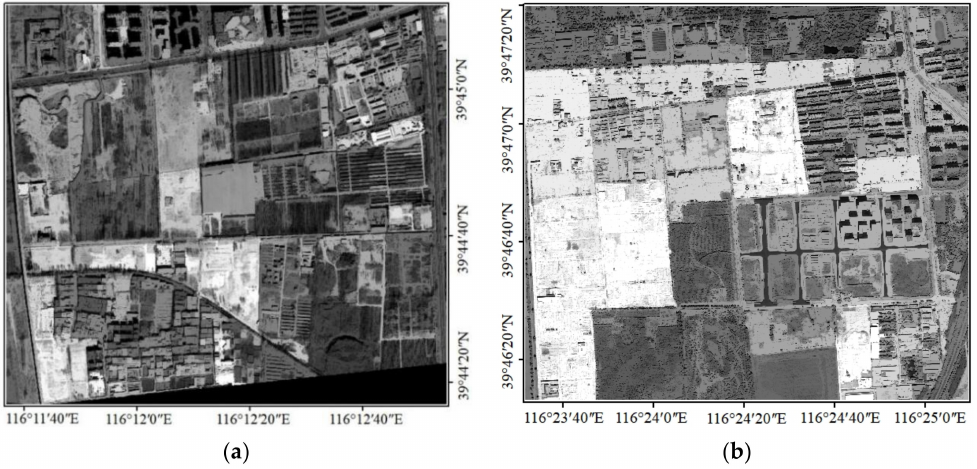
Figure 11. The results of the morphological opening reconstruction: ( a ) Area A; ( b ) area